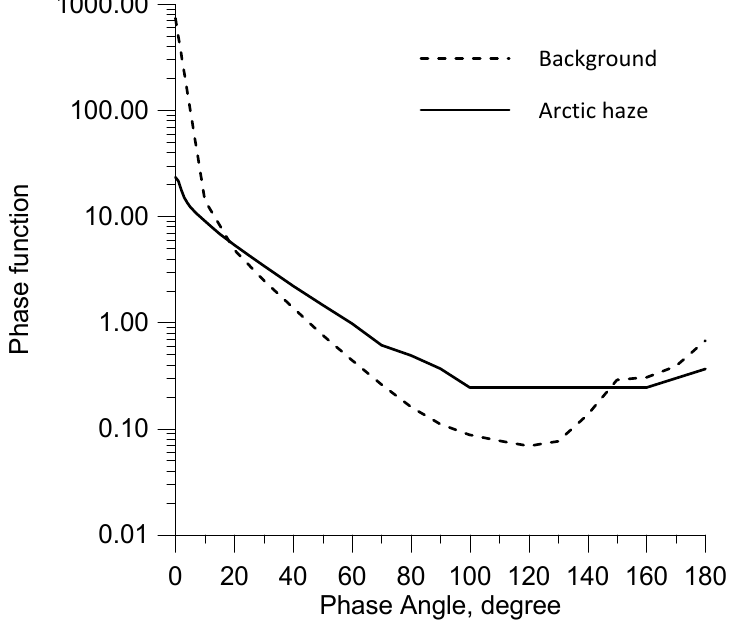
Figure 1. Phase function of two aerosol types used in the retrieval (adapted from [9]).